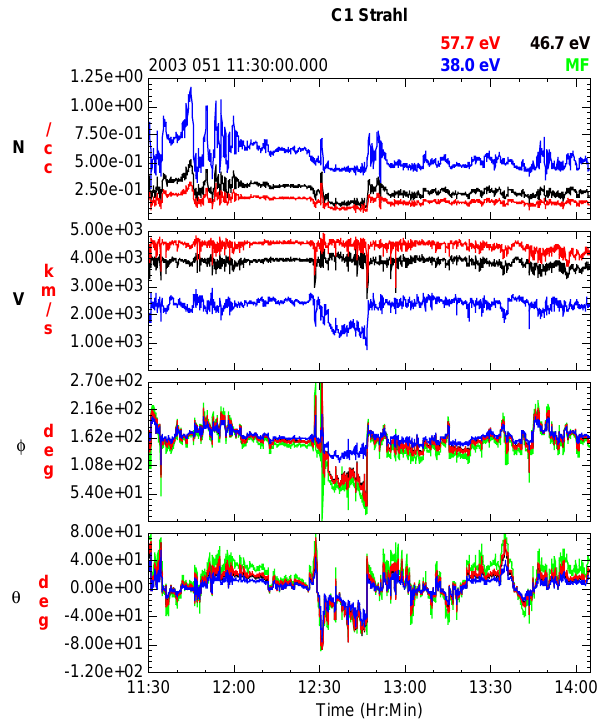
Fig. 4. Plots of the electron density and spherical velocity com- ponents for integrations starting a 38.0eV (blue), 46.7eV (black) and 57.5eV (red). Also shown are the angular components of the magnetic field (green).